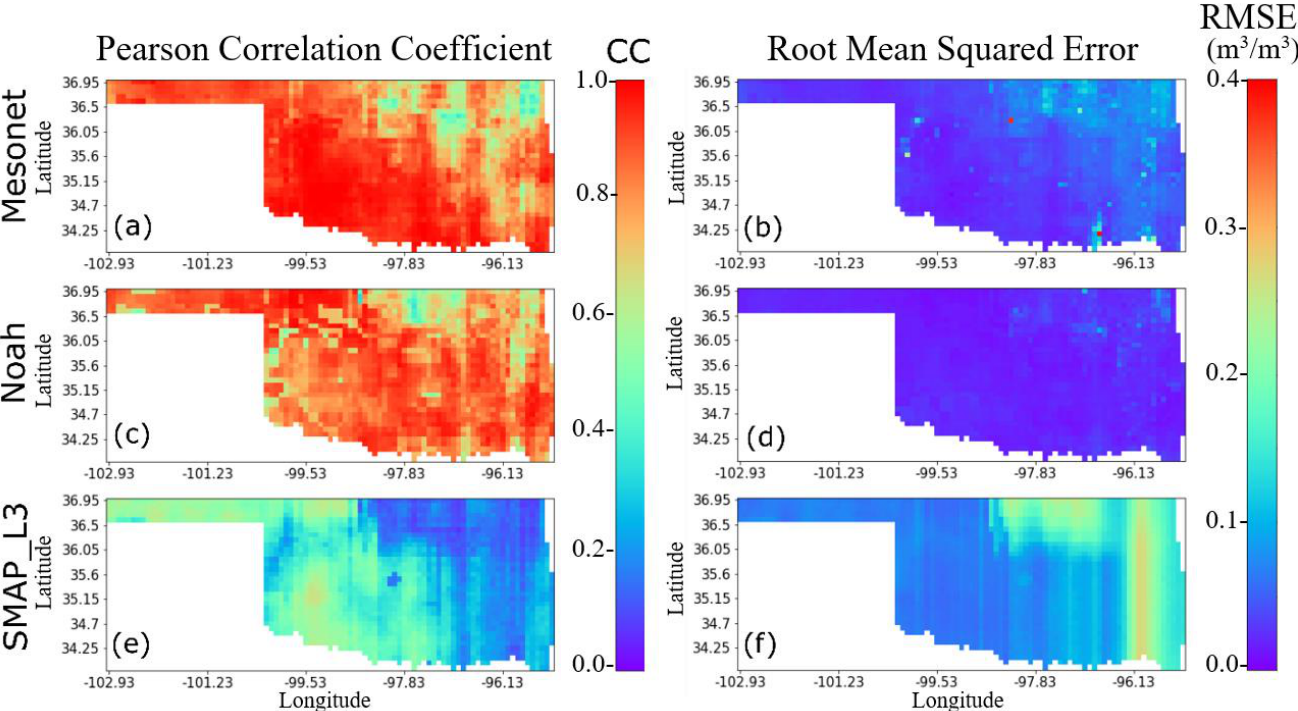
Figure 7. Product intercomparison assessment through CC (left column) and RMSE (right column) after applying the TC method for Mesonet (first row), Noah (second row), and SMAP (third row) surface soil moisture products based on morning 6 a.m. values from April 2015 to July 2019, integrated (averaged) only during the fall season months (i.e., September, October, and November). Table 7. Climate-division averaged CC and RMSE from the TC triplets at local 6:00 a.m. values from April 2015 to July 2019, for Mesonet, Noah, and SMAP during the fall season months (i.e., September, October, and November) for nine climate divisions in Oklahoma.